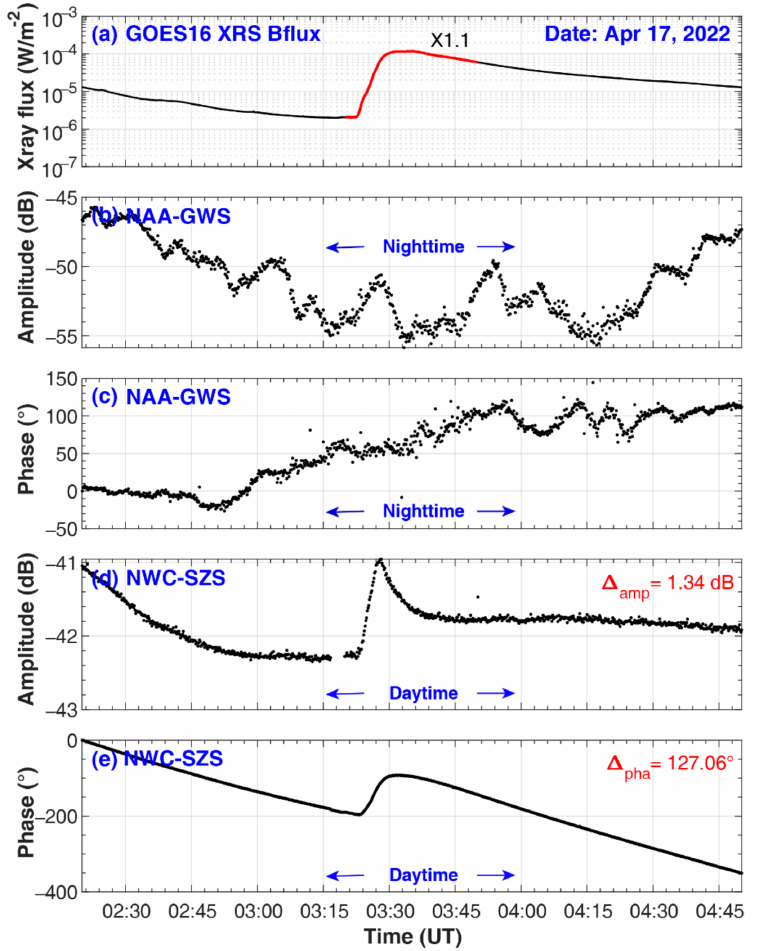
Figure 3. Same as Figure 2, except for the solar flare occurred on 17 April